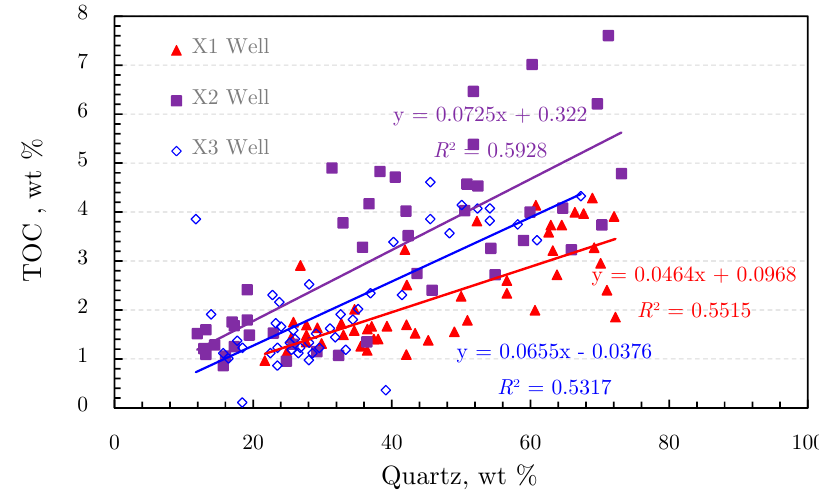
Figure 6. The relationship between quartz and TOC contents in Longmaxi Formation.